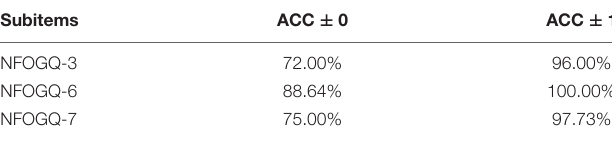
TABLE 7 | NFOG-Q prediction results.